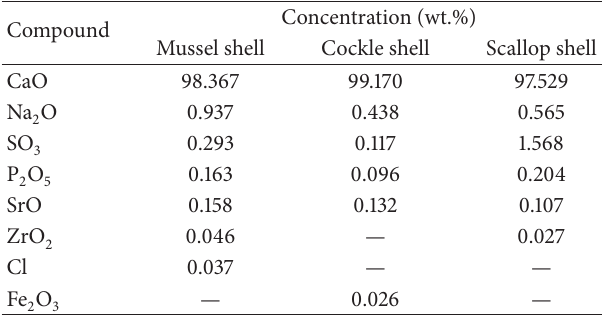
Figure 3: XRD patterns of waste mussel, cockle, and scallop shell calcined at 1,000 ∘ C ( ◼ : CaO). Table 1: Chemical compositions of waste shell-derived catalyst.